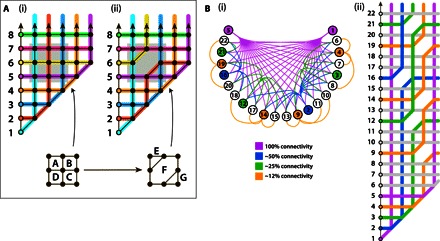
Lattices with bespoke connectivity.(A) Strategic disruptions to the stabilizer lattice can control the routing of logical x operators. Starting from a regular lattice section (i) and replacing the central four stabilizers A, B, C, and D with three stabilizers E, F, and G (where F is a six-body stabilizer) and removing a physical spin results in a new lattice (ii) where the paths of the x operators for logical spins 2 and 6 are reflected. (B) Designing nontrivial connectivities via such reflections: Diagram (i) is a connectivity graph showing a highly connected (but not all-to-all) relationship between 22 nodes. Diagram (ii) is a lattice formed from three-, four-, and six-body stabilizers, arranged so as to realize that connectivity; for every linked pair in (i), there is at least one physical spin in (ii) representing the relative orientation of the logical spins.